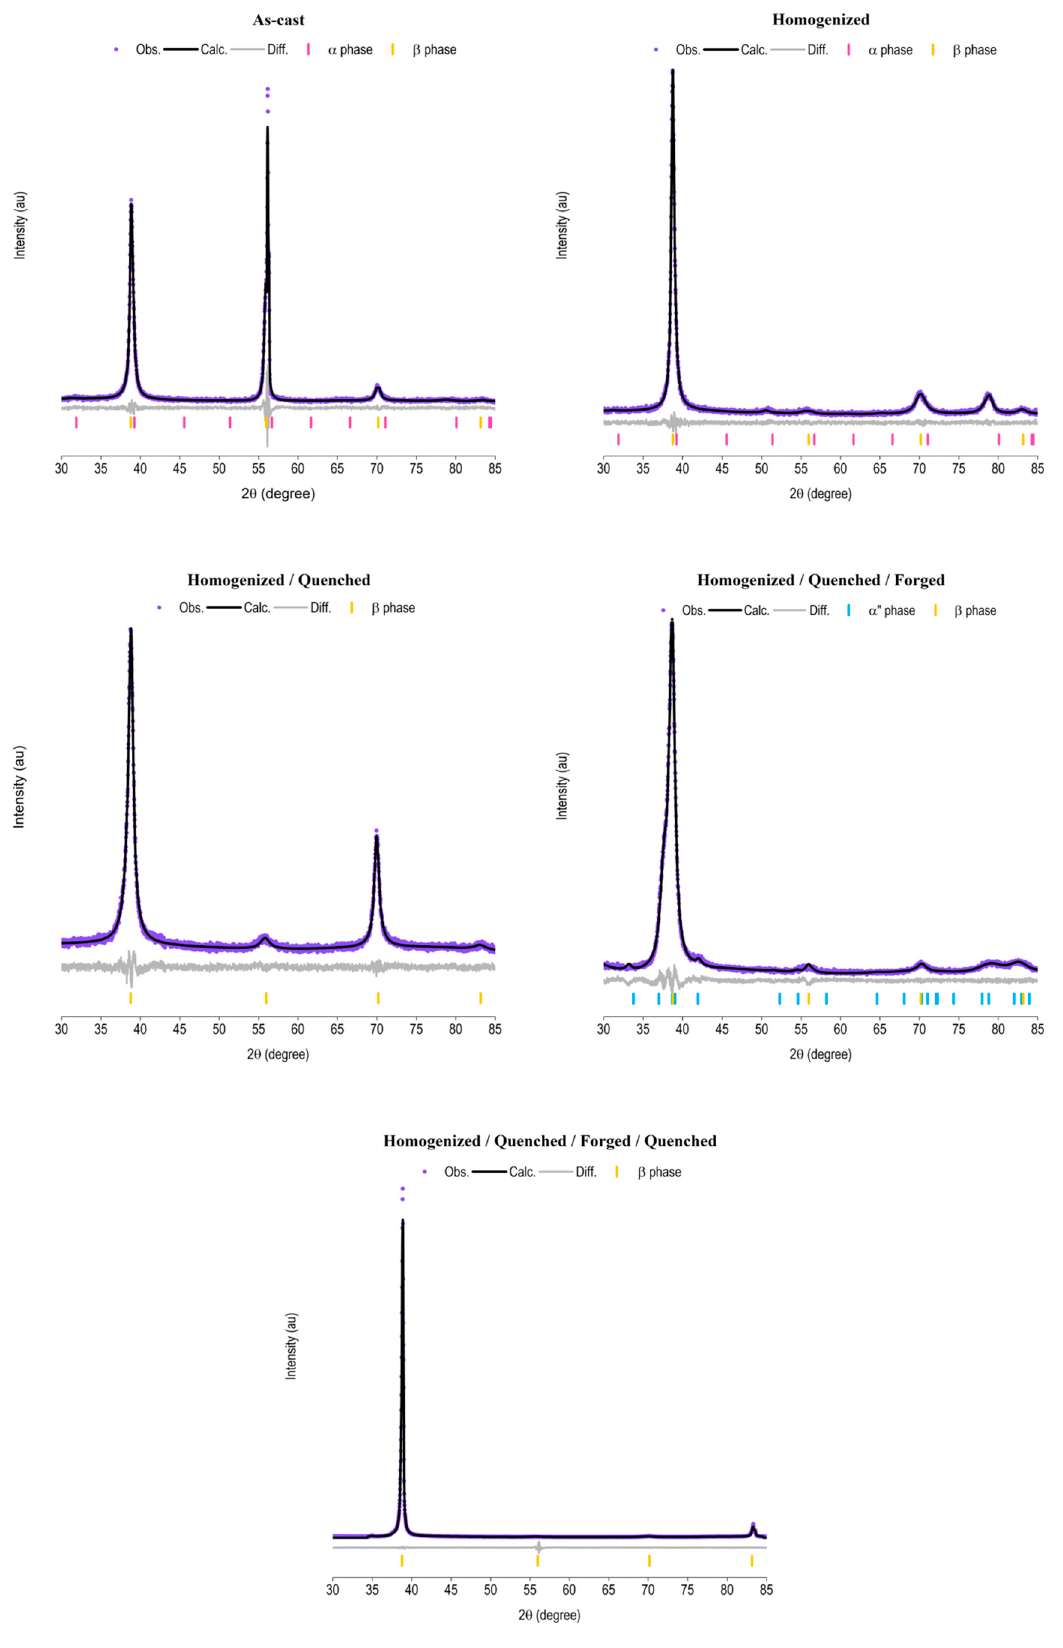
Figure 2. Rietveld refinement of the X-ray diffraction pattern of the Ti 10 Mo 8 Nb 6 Zr alloy. The analysis was carried out after each processing step of the alloy: ( a ) as cast, ( b ) after homogeniza-